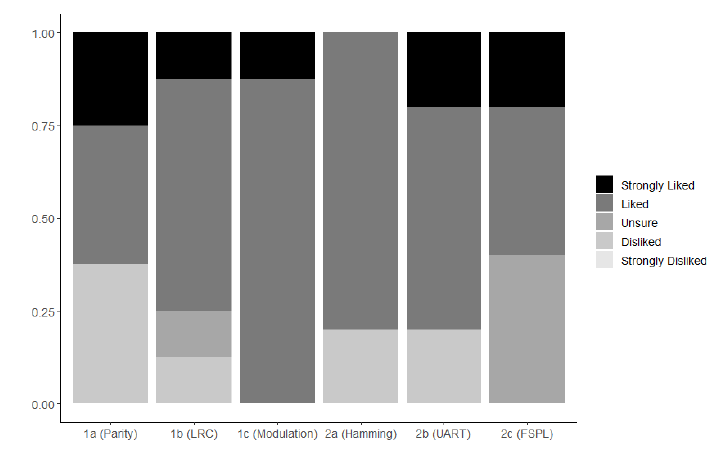
Figure 5. Survey results rating puzzle enjoyment.